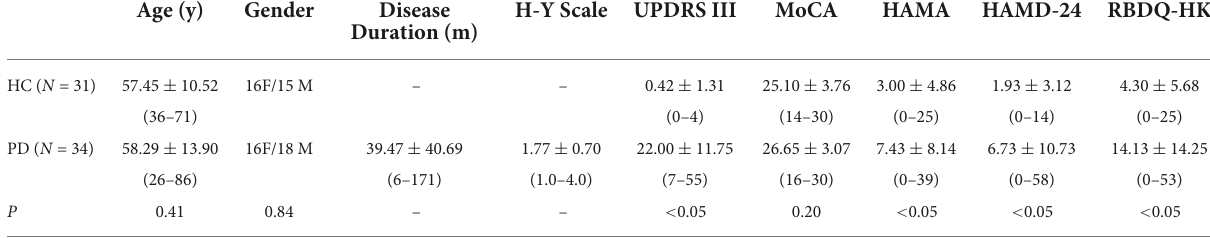
TABLE 1 Clinical and demographic data of the PET/MR